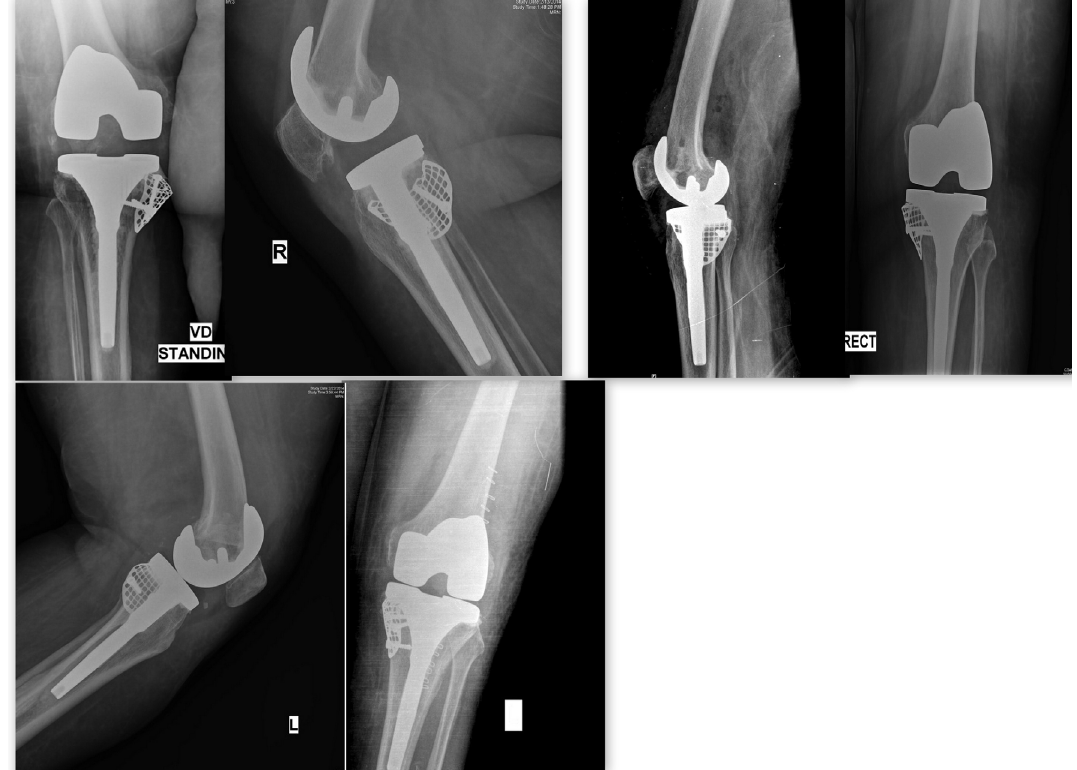
Figure 4. Post-operative X-rays with incorporation of impacted bone graft and well-aligned knee